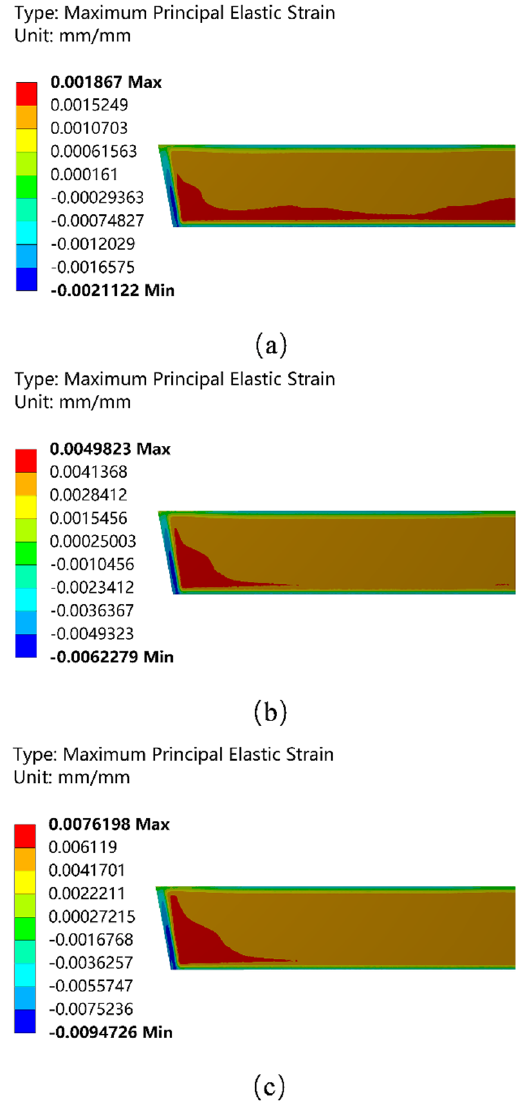
Figure 5. Distribution of the maximum principal elastic strain field of the working layer. ( a ) The first stage of preheating; ( b ) the second stage of preheating; and ( c ) the third stage of preheating